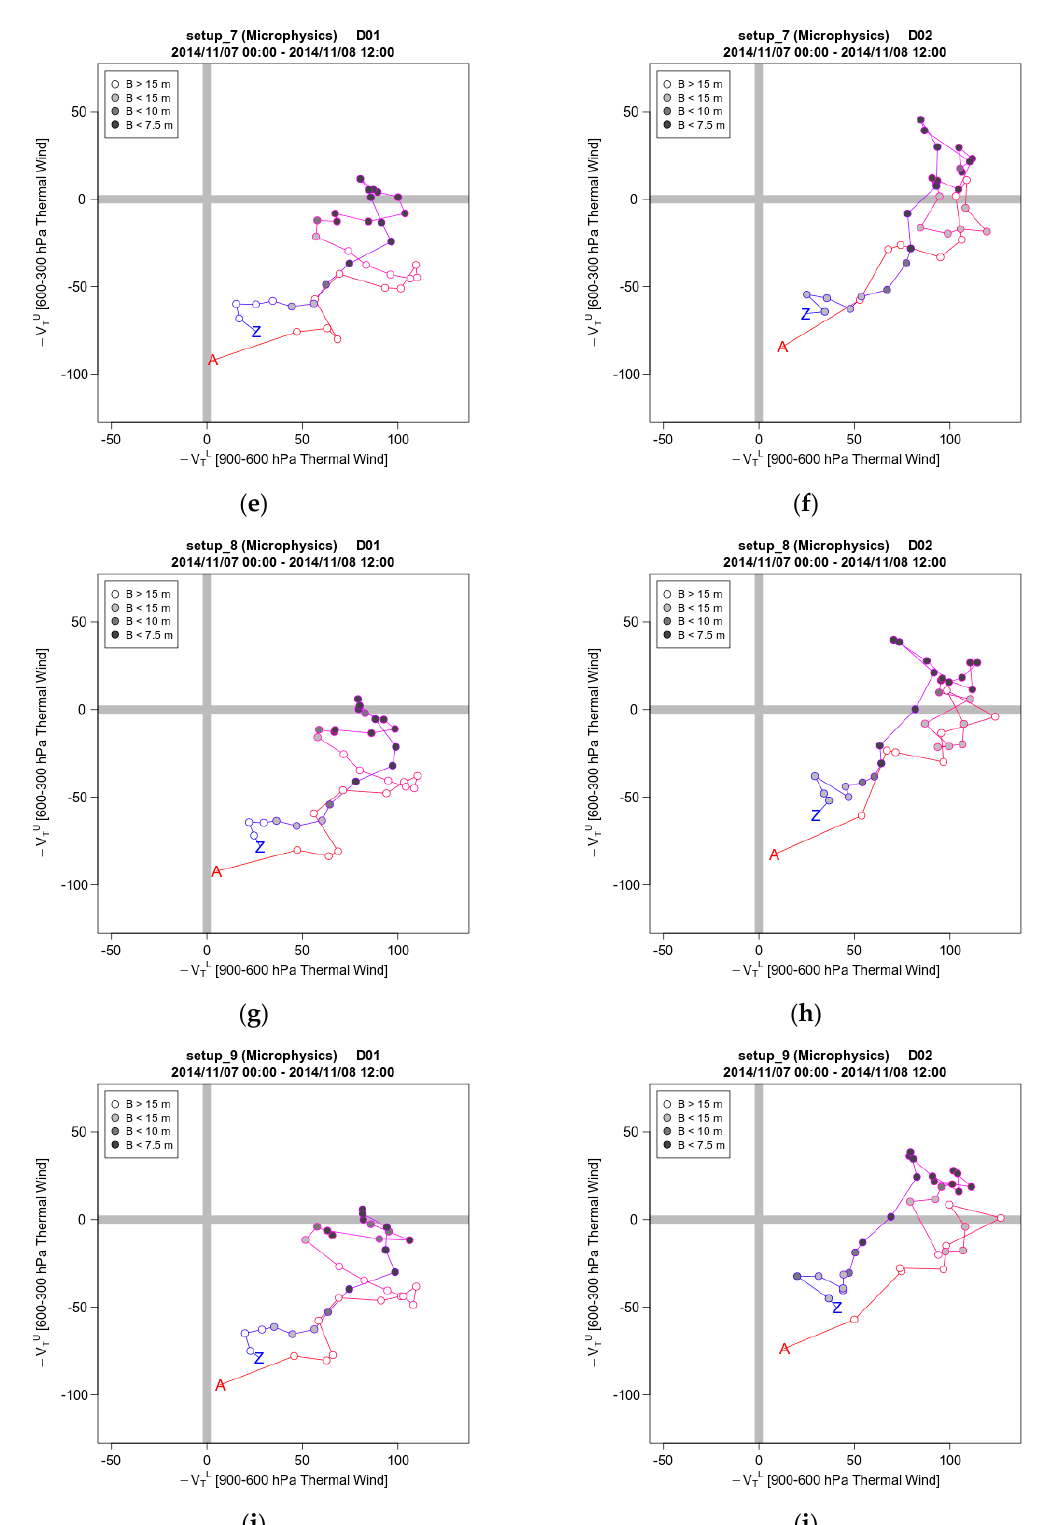
Figure 11. Phase space diagrams of –V T L (900–600 hPa) against –V T U (600–300 hPa) as predicted from model MP experiments in D01 for: ( a ) setup_5, ( c ) setup_6, ( e ) setup_7, ( g ) setup_8, ( i ) setup_9 and in D02 for: ( b ) setup_5, ( d ) setup_6, ( f ) setup_7, ( h ) setup_8, ( j ) setup_9. Circles show the position at hourly intervals while filled circles denote the position when the symmetry is less than 10 m.3.3. Convection and Radiation sensitivity simulations.